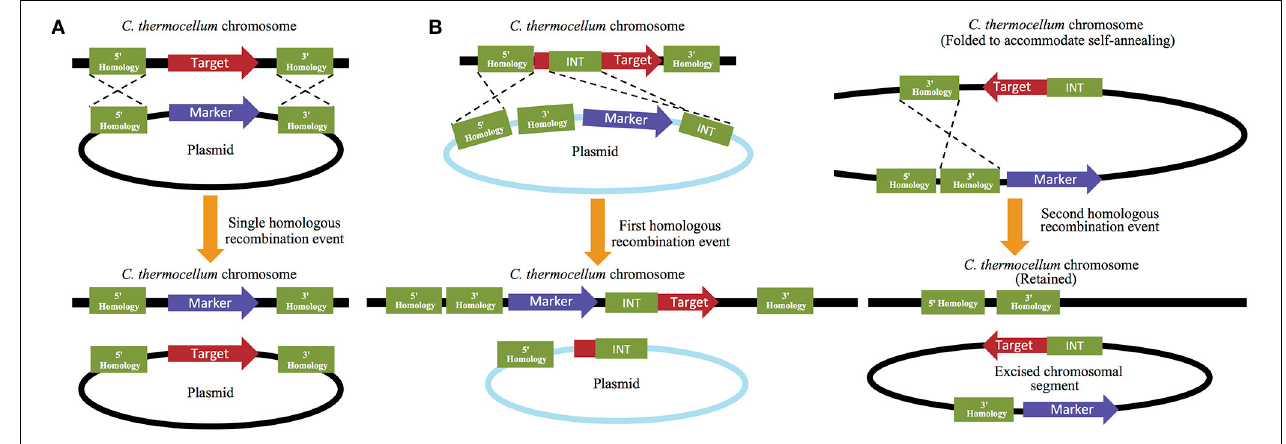
FIGURE 3 | Targeted gene deletion in C. thermocellum . Targeted gene deletions that (A) retain their selection markers can be performed quickly using only a single homologous recombination step, while strategies that (B)